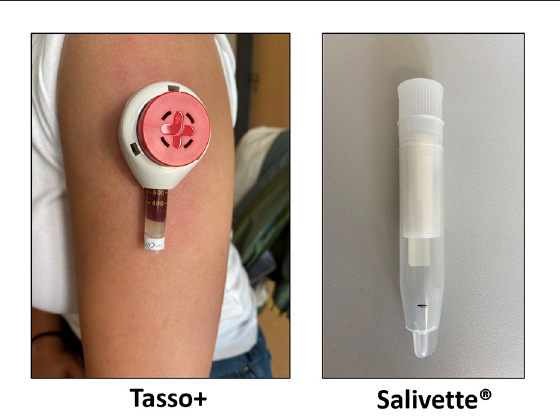
FIGURE2 Capillary blood upper-arm self-collection device (Tasso + ) and saliva collection device (Salivette ®